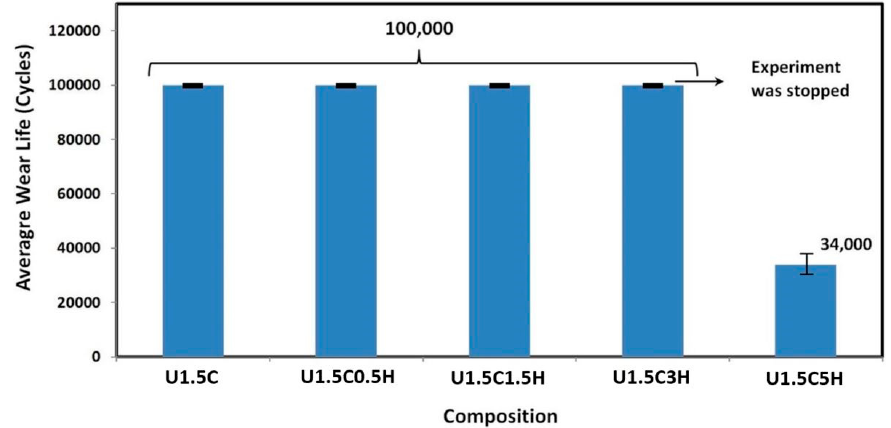
Figure 8. Average wear life of hybrid nanocomposite coatings, recorded after a wear test conducted at a normal load of 12 N, and a sliding velocity of 0.1 m/s for 100,000 cycles.